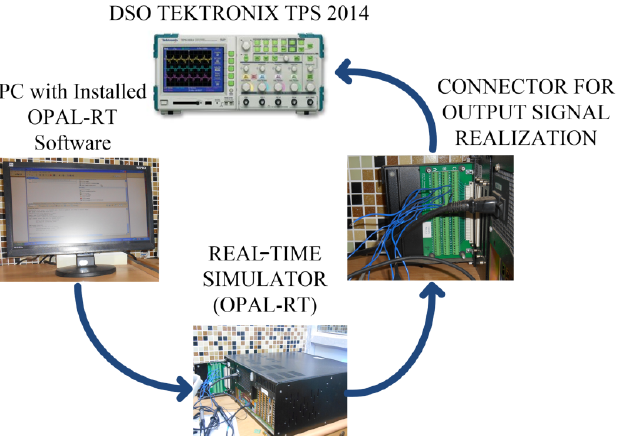
Figure 13. OPAL ‐ RT simulator connected to the host PC via ethernet and to the DSO via connecting Figure 13. OPAL-RT simulator connected to the host PC via ethernet and to the DSO via connect- probes. ing